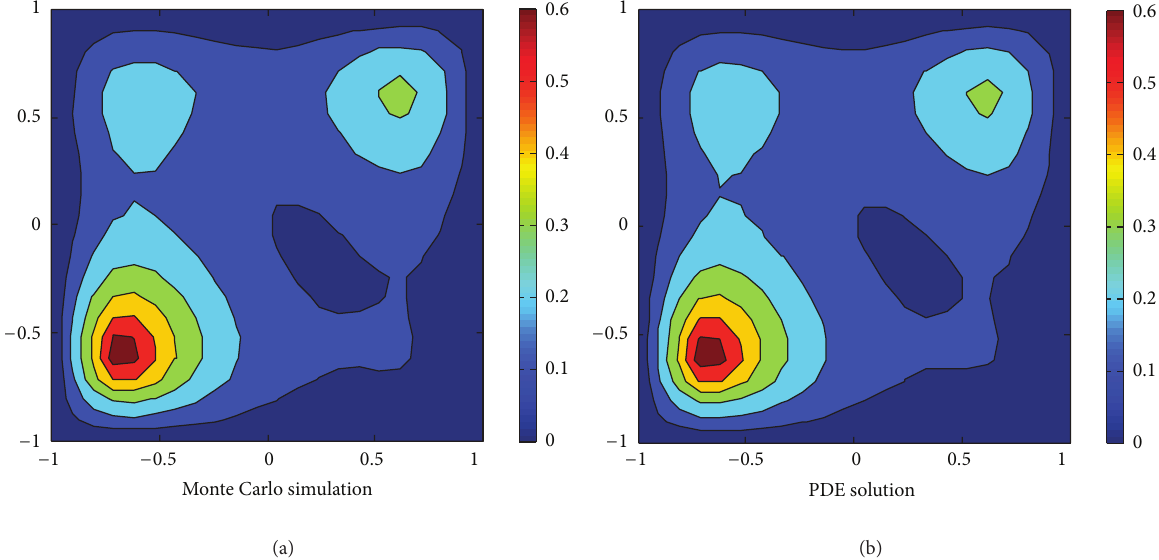
Figure 5: The Monte Carlo simulation and the PDE solution of a 2D 1-step network of Type I communicating neighbors.